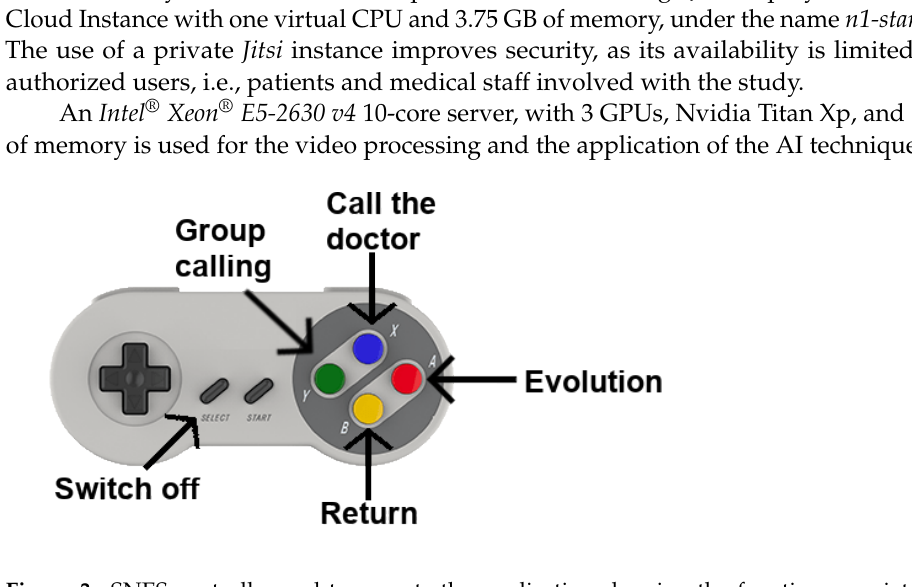
Figure 3. SNES controller pad to operate the application showing the function associated with each